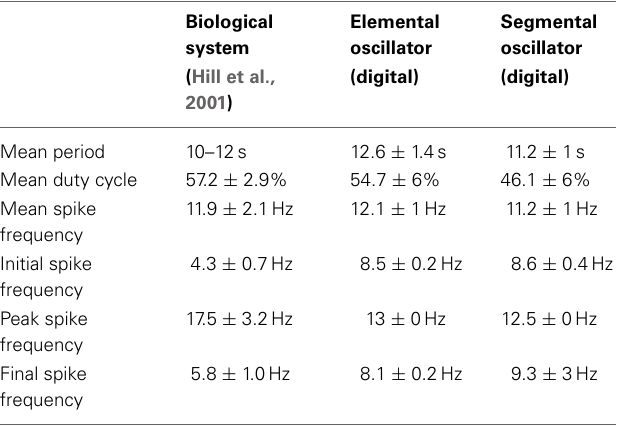
Table 3 | Variation in the mean period depending on the τ reg parameter.